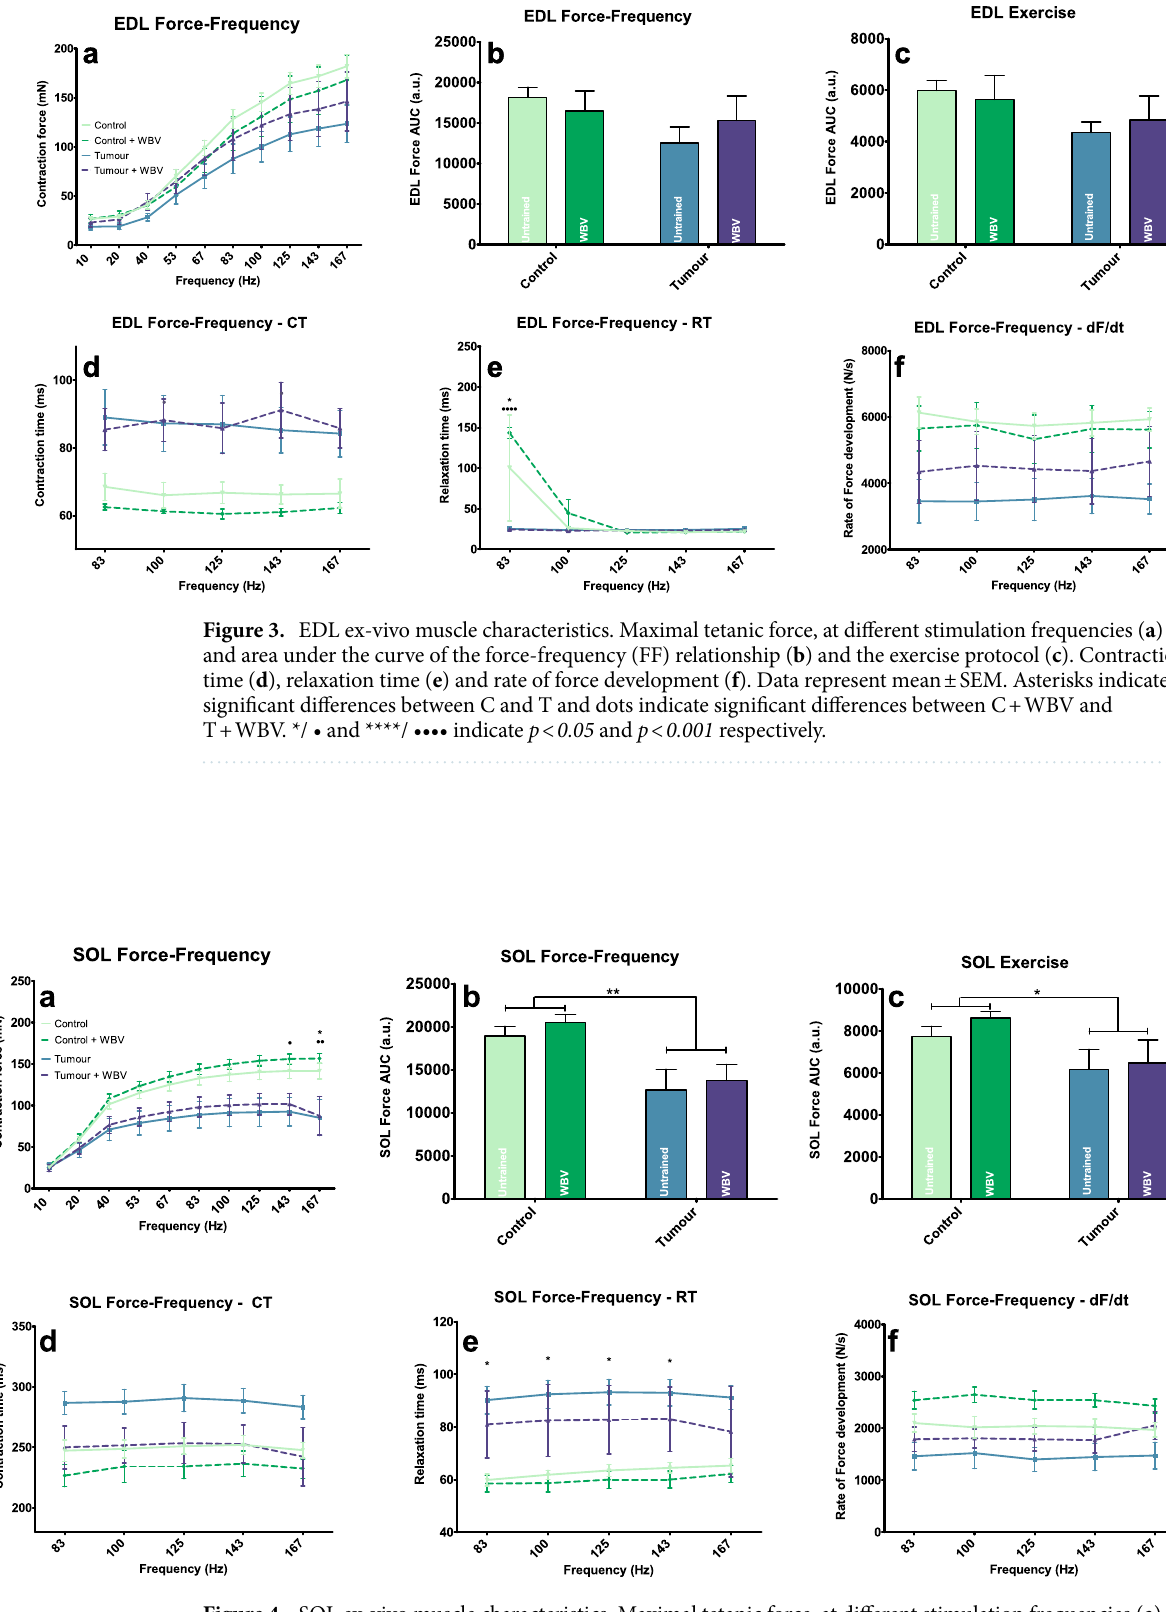
Figure 4. SOL ex-vivo muscle characteristics. Maximal tetanic force, at different stimulation frequencies ( a ) and area under the curve of the force-frequency relationship ( b ) and the exercise protocol ( c ]. Contraction time ( d ), relaxation time ( e ) and rate of force development ( f ). Data represent mean ± sem. Asterisks indicate significant differences between C and T and dots indicate significant differences between C + WBV